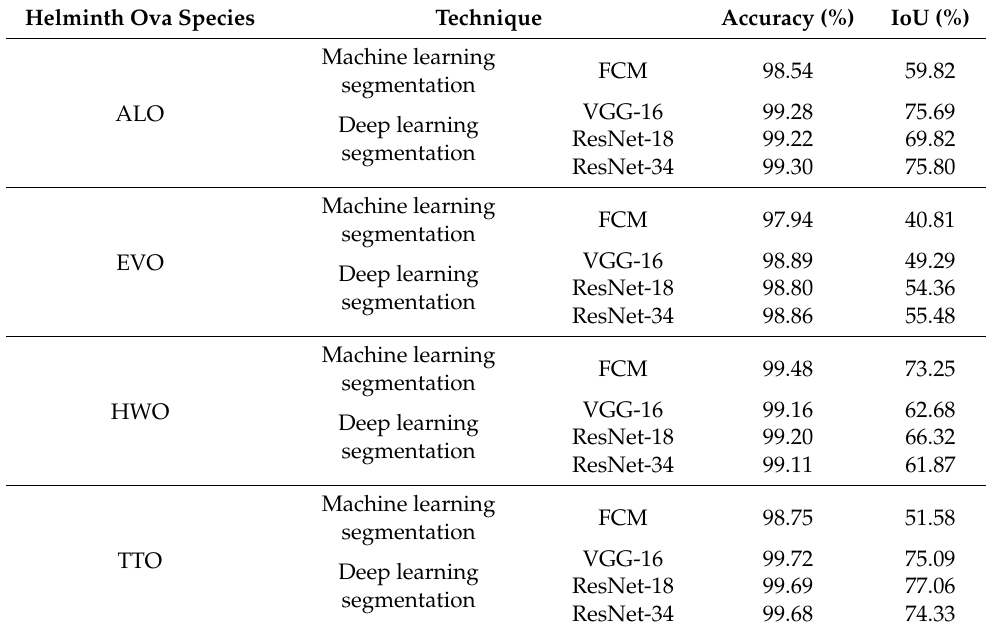
Table 3. Quantitative measure for the segmentation performance of helminth ova